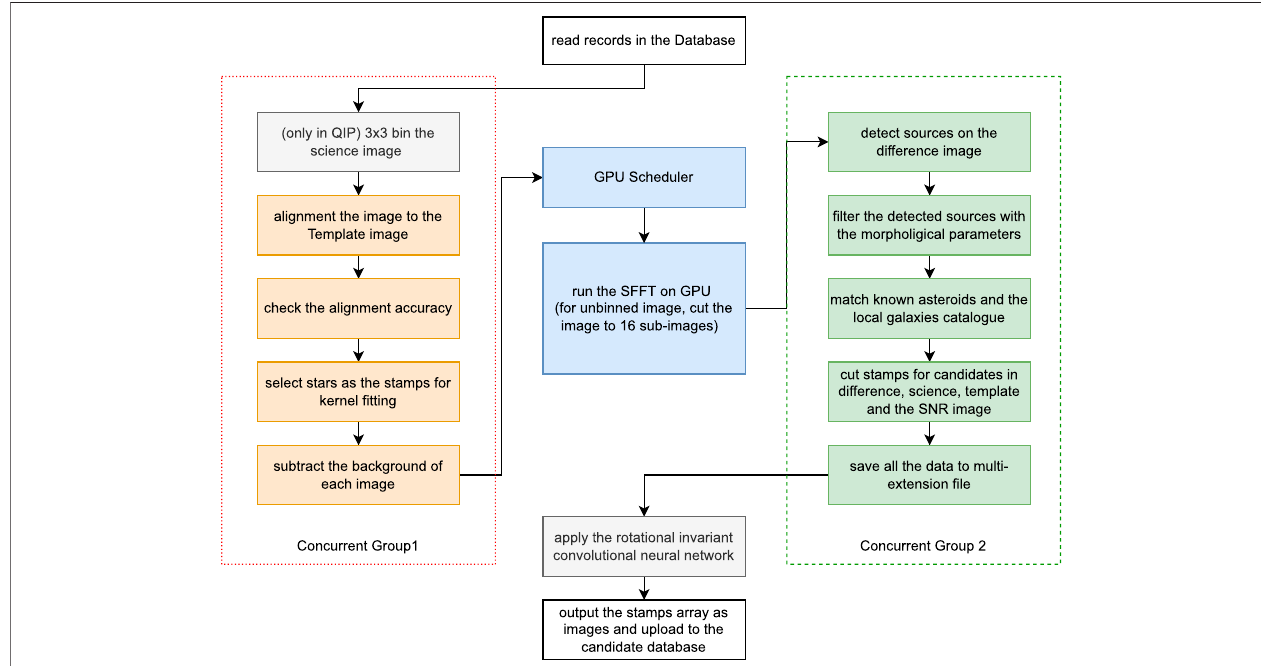
FIGURE 6 | This fl owchart shows the transient detection pipeline for AST3-3. The pipeline is divided into four components. The left box shows the fi rst concurrent group that contains the preparations for image subtractions. The middle part is the SFFT subtraction procedure, which calls the SFFT functions with a GPU resource scheduler. The right box shows the second concurrent group for candidate detection on the difference images. The bottom part shows the candidate classi fi cation and the data exchange of the